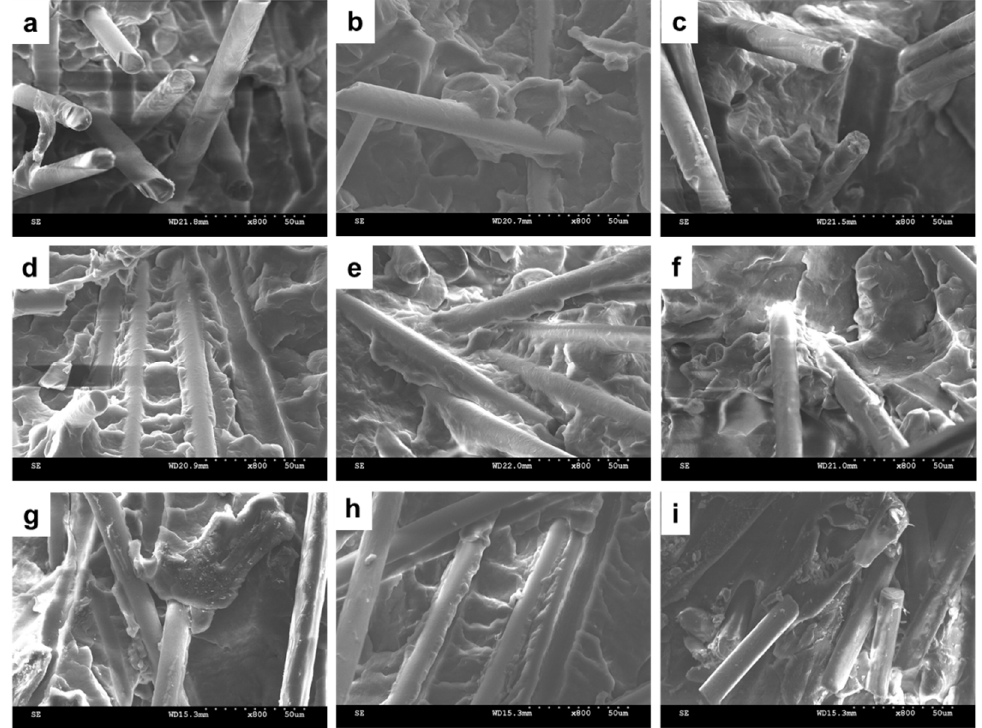
Figure 10. SEM images (800×) of PP/SGF composites, which are incorporated with ( a ) 0 wt % of a coupling agent; ( b ) 2 wt %; ( c ) 4 wt %; ( d ) 6 wt %; and ( e ) 8 wt % of PP-g-MA; as well as ( f ) 2 wt %; ( g ) 4 wt %; ( h ) 6 wt %; and ( i ) 8 wt % of SEBS-g-MA.